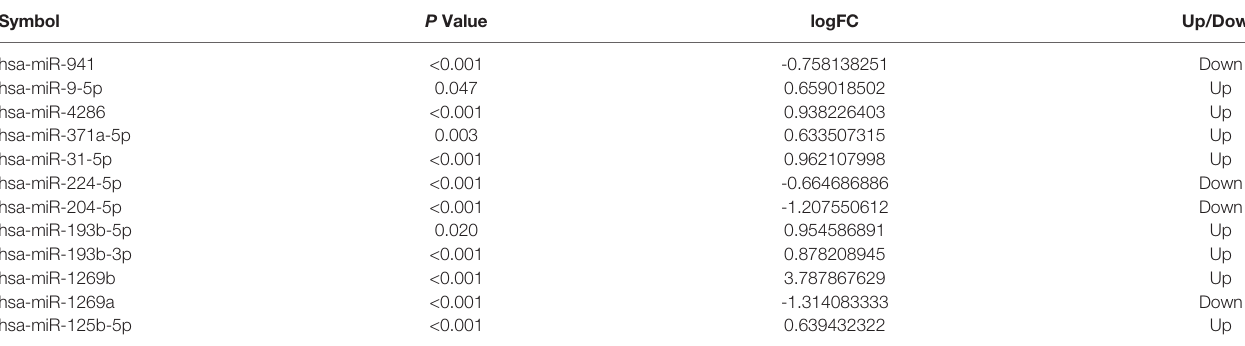
IVF-ET, in vitro fertilization-embryo transfer; FC, fold change.